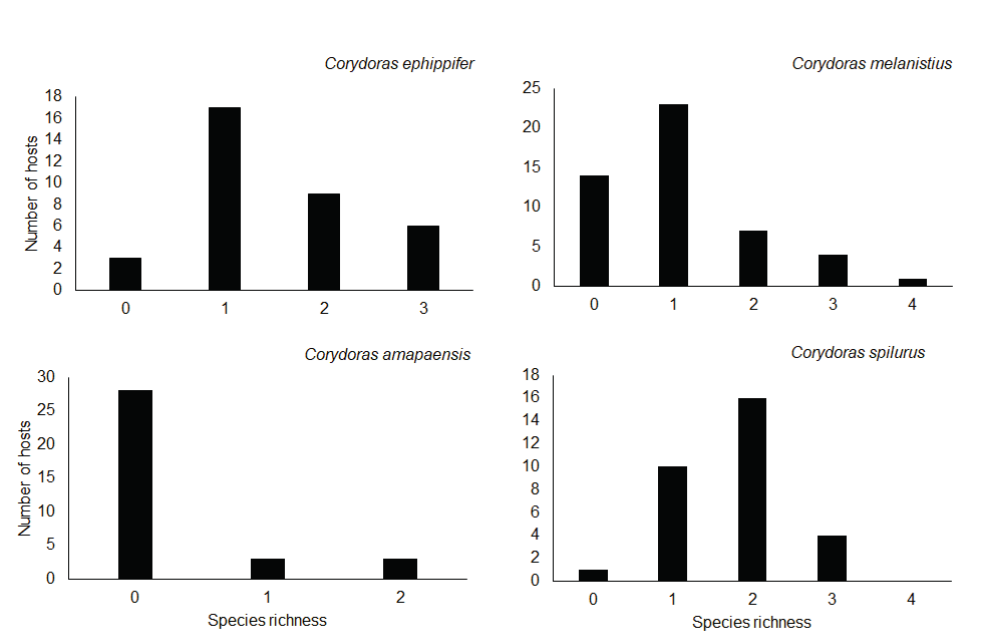
Figure 2 - Species richness of parasites for four species of Corydoras endemic to the eastern Amazon